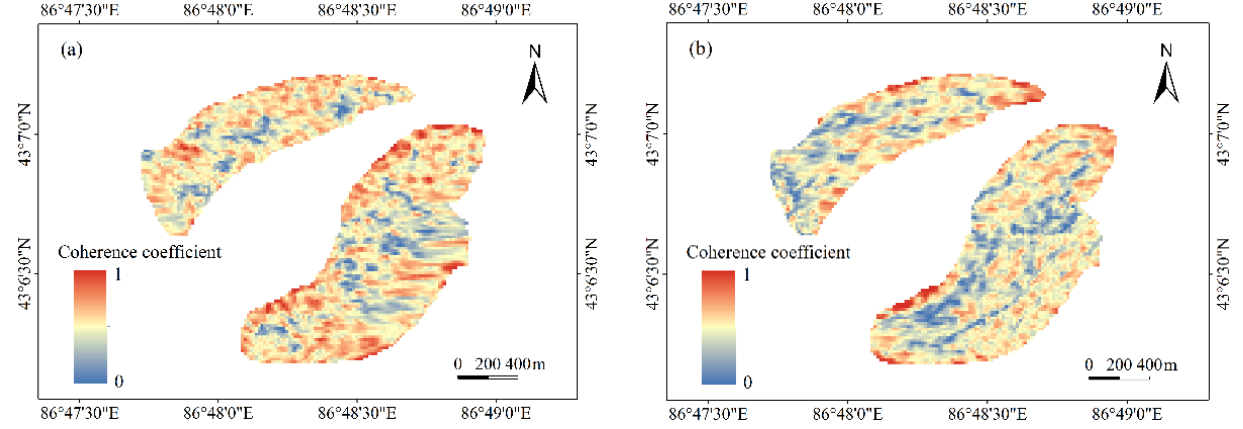
Figure 3. Coherence coefficient diagram. ( a ) the ascending Sentinel-1 pairs in 2017-06-11 –